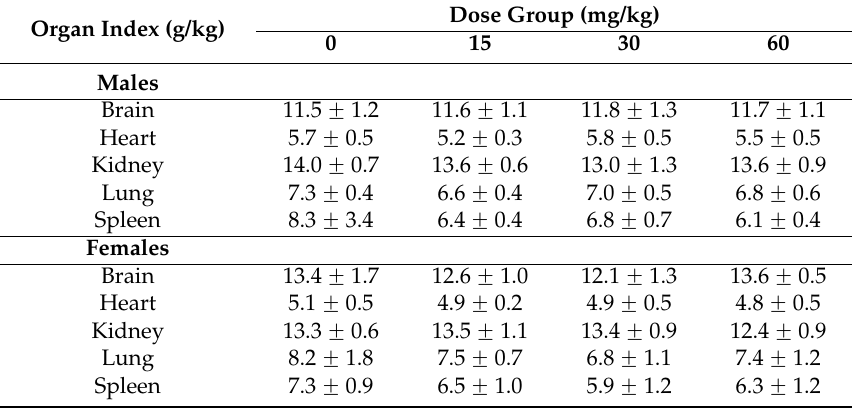
Table 5. Effects of SalB-Rg1 on the organ index with a seven-day repeated dose.